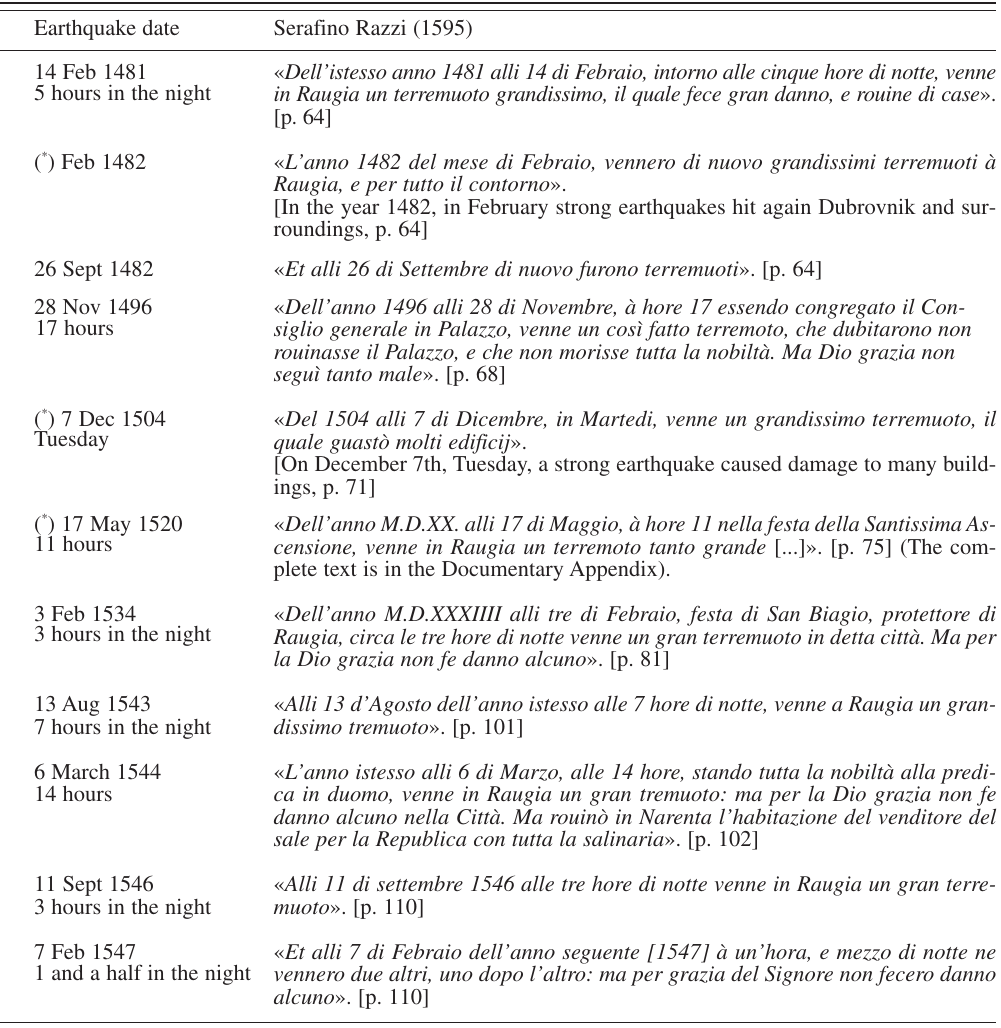
Table III. Records on earthquakes at Ragusa/Dubrovnik (late 15th to mid 16th century). Earthquake